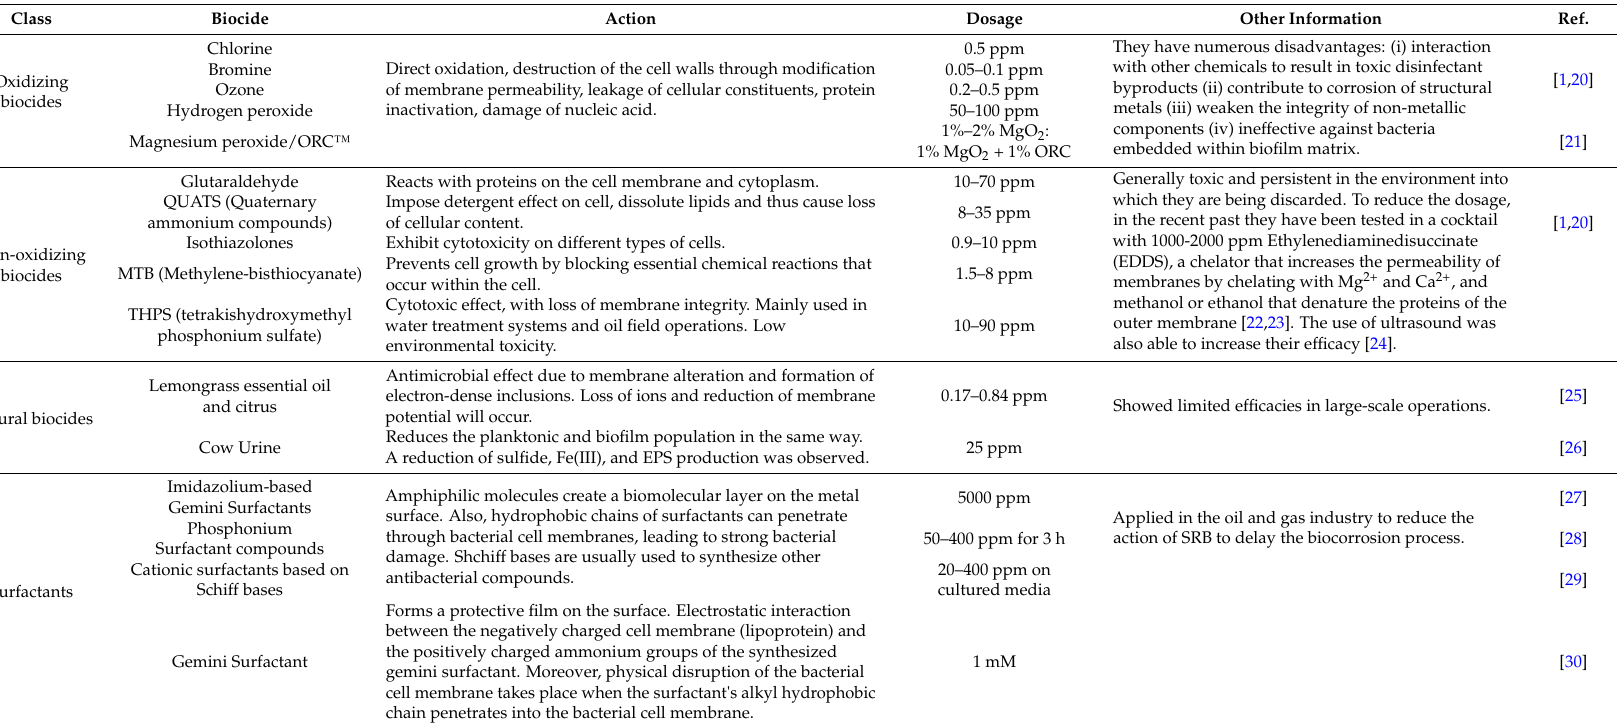
Table 2. Commonly used reagents and their mode of action, required dosage and associated